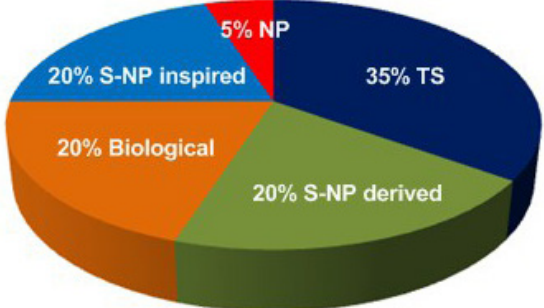
Figure 1 - Drug origins: TS, totally synthetic; S–NP inspired, synthetics inspired by NPs; S–NP derived, synthetics derived from NPs; Biologicals + vaccines; NP, isolated